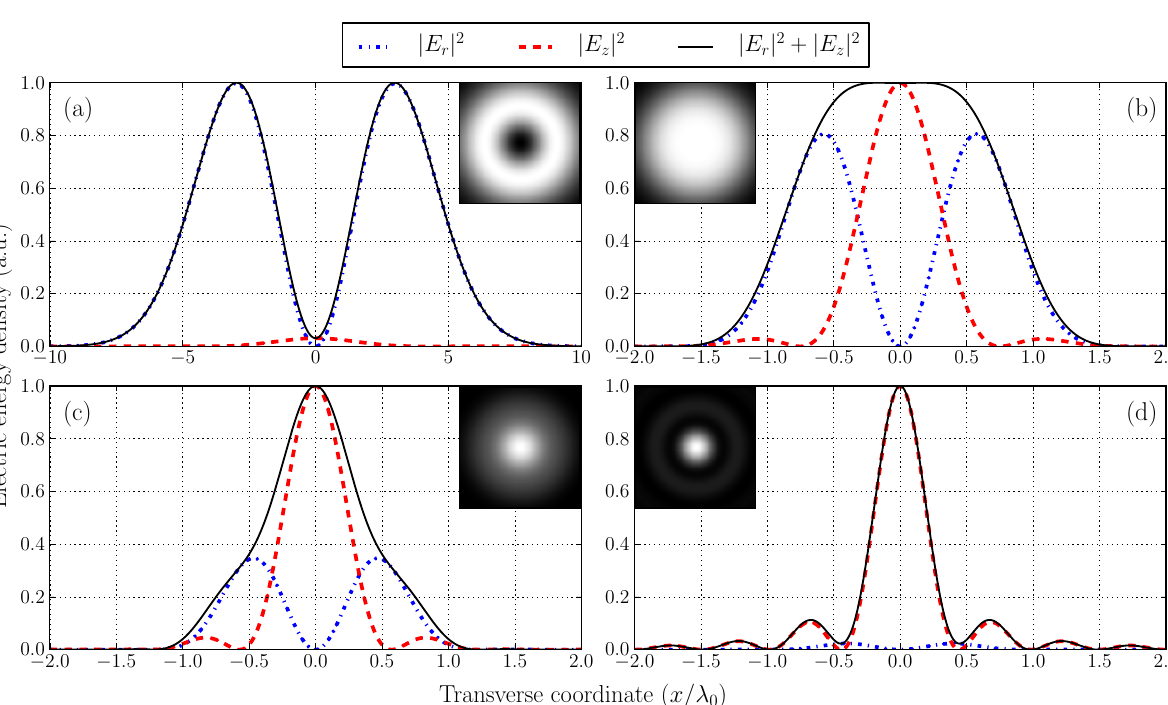
2 / 2 of E = (cid:15) e 0 | | z z = 350 ; ( b ) k = 10 ; 0 0 0 0